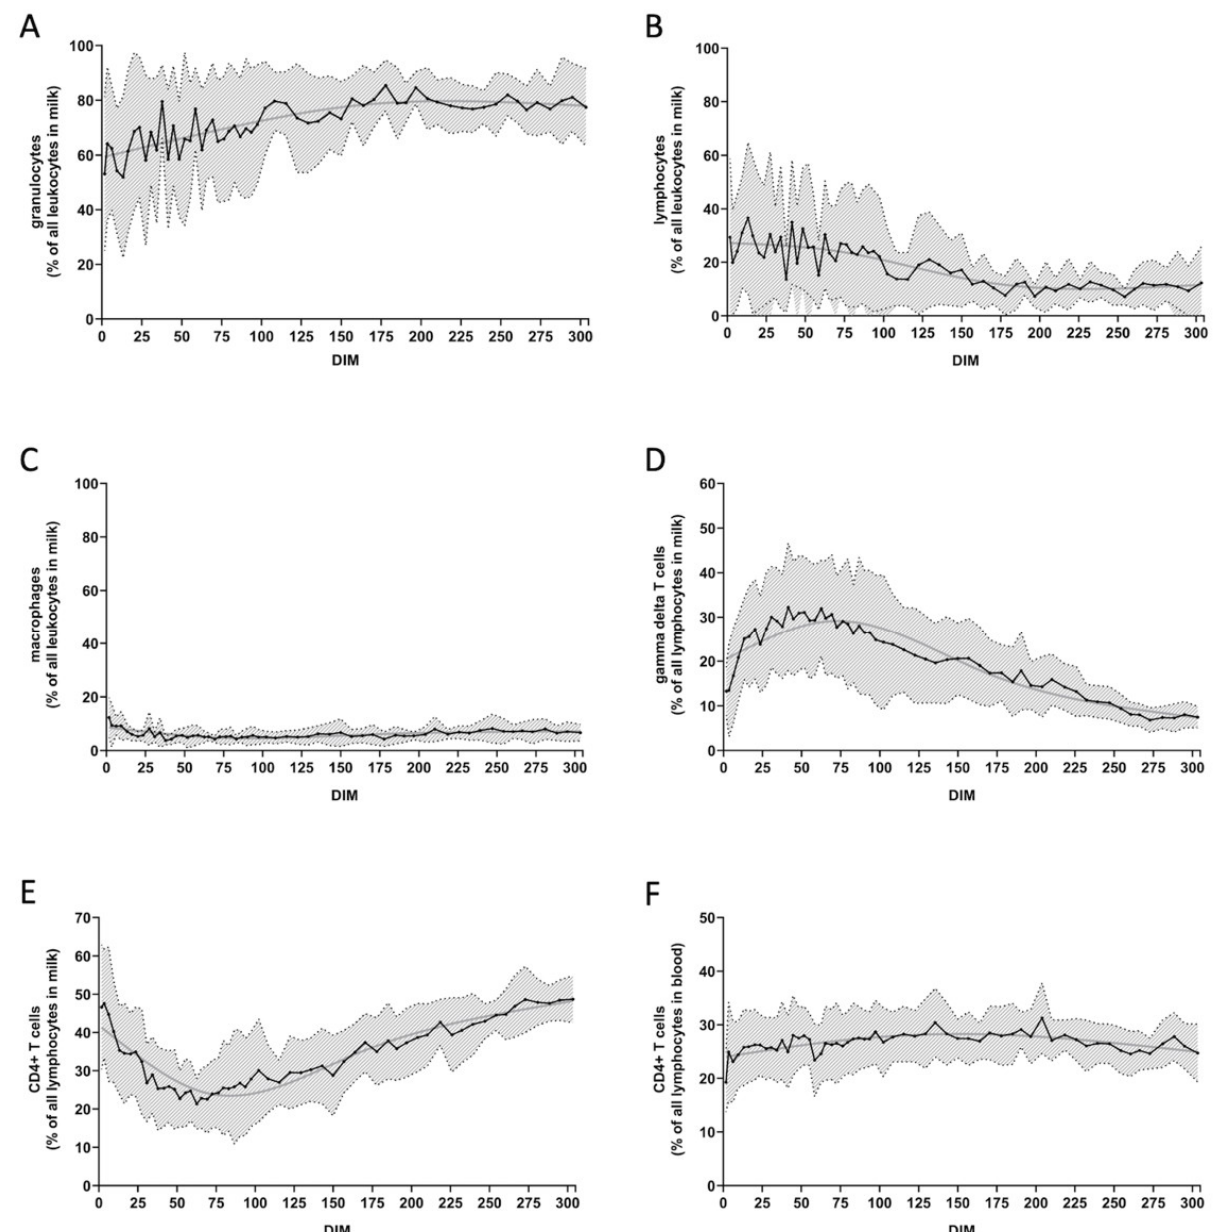
Figure 1. Mean percentages of cell subpopulations during the course of lactation, with standard deviation and smoothing spline. On average, there are 55 (52–57) data points each: ( A ) milk granulocytes; ( B ) milk lymphocytes; ( C ) milk macrophages; ( D ) milk gamma delta T cells; ( E ) milk CD4 + T cells; ( F ) blood CD4 + T cells.